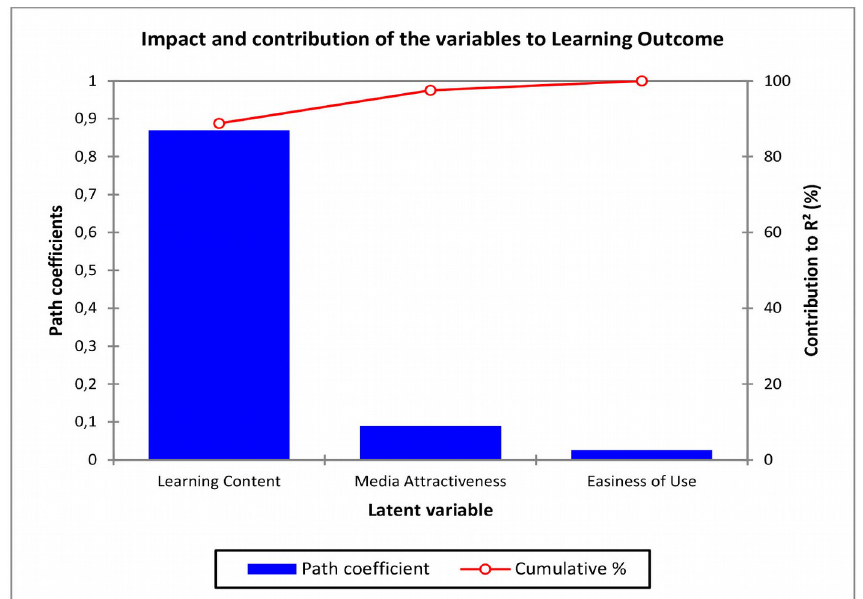
Figure 4. Impact and contribution of the variables to Learning